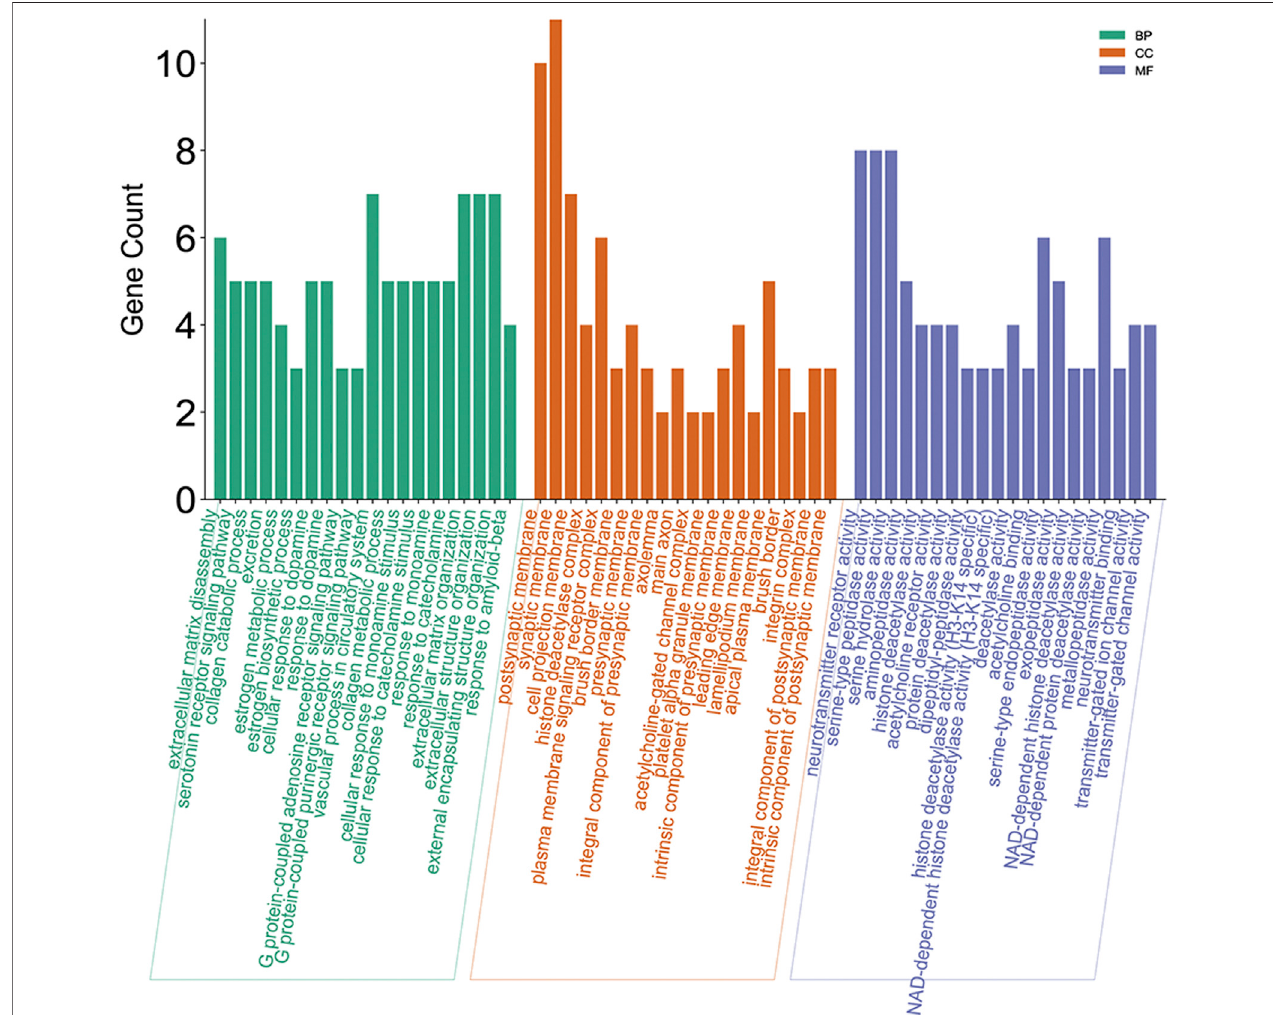
FIGURE 9 | Gene ontology enrichment processing of the core targets of the regulating metabolic networks of matrine.